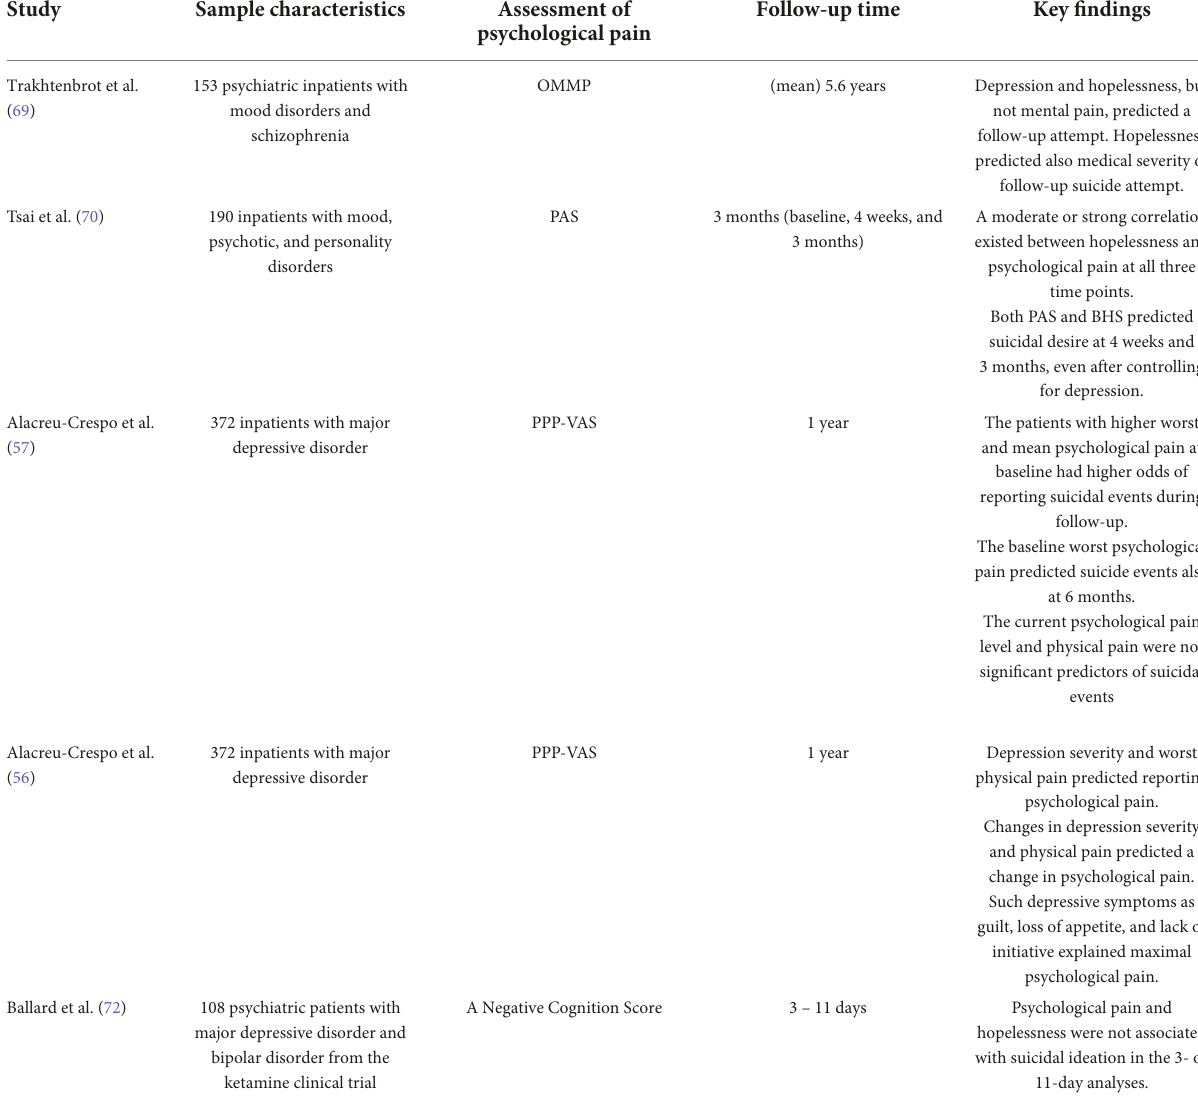
TABLE 2 Prospective studies on psychological pain in psychiatric